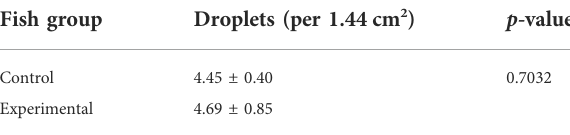
TABLE8Histologicalanalysesoflipiddropletscountinlivertissue( n = 8intotalwith4 fi shperfeedgroup).Dataarepresentedasmean± standard deviation. Statistical signi fi cance was set at p -value < 0.05.